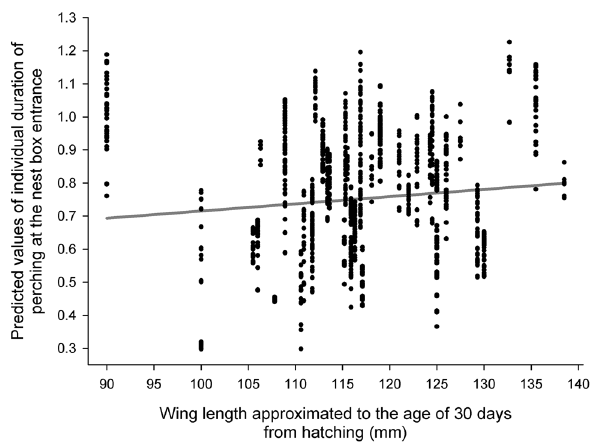
Figure 5. Predicted values of the log-transformed individual duration of nestlings’ perching at the nest box entrance during the night plotted against the wing length extrapolated to the age of 30 days from